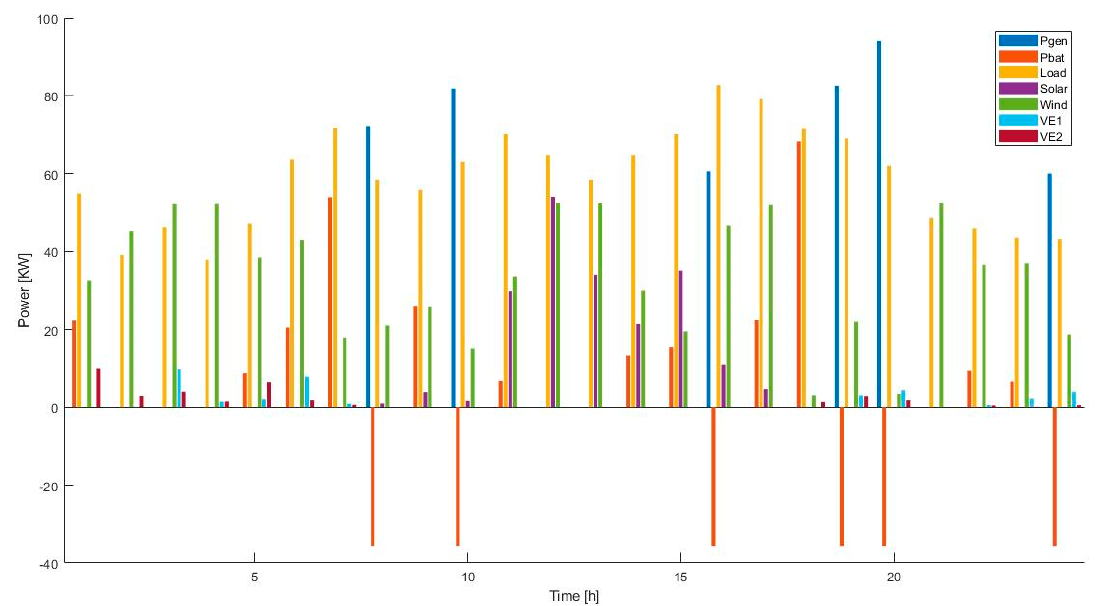
Figure 5. MG Operation during 24 hours when the battery storage system is getting to the end of its useful life.